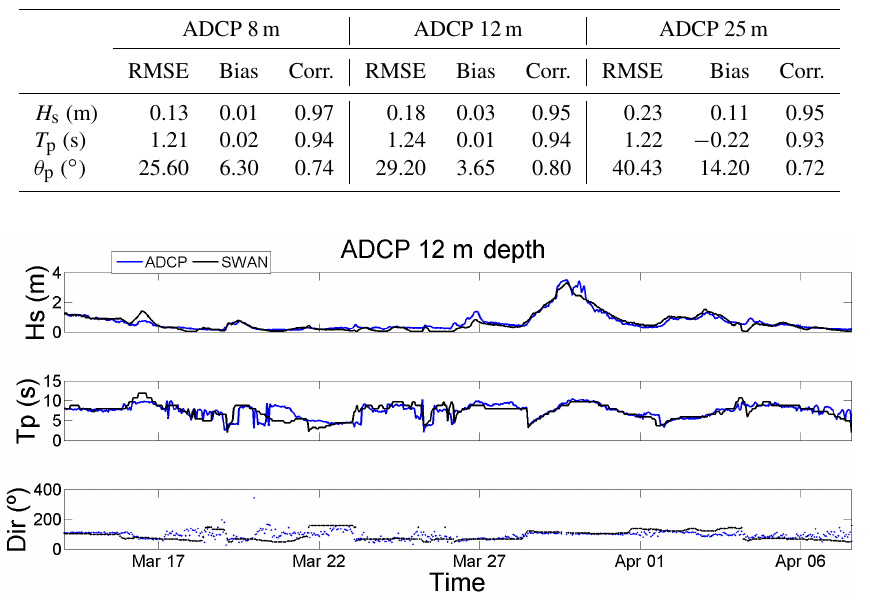
Figure 8. H s , T p and wave direction as modelled by SWAN and observed at the ADCP deployed at 12m depth in the Cala Millor beach.